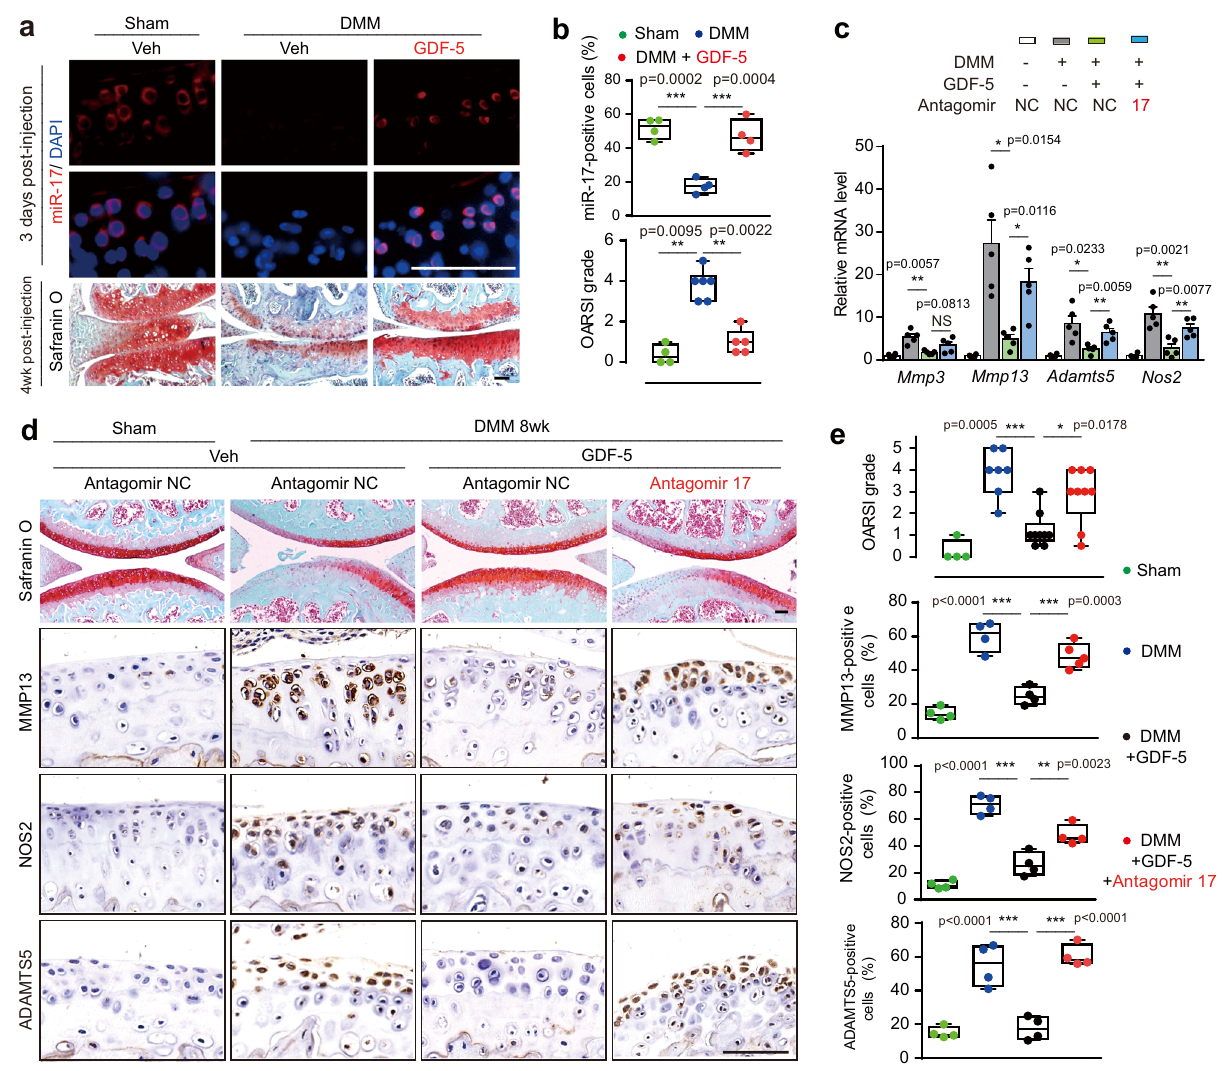
Fig. 3 Endogenous miR-17 was upregulated by GDF-5 to suppress cartilage destruction in DMM mice. a , b FISH for miR-17 and safranin O/fast green staining of joint sections ( a ), and quanti fi cation of miR-17-positive cells and OARSI scores ( b ). Veh (PBS) or GDF-5 (100 ng per injection) was injected weekly for 4 weeks, beginning at 4 weeks after sham or DMM surgery. n = 4 mice per group for cell counting. For OARSI grade, n = 4 mice (sham); n = 6 mice (DMM); n = 5 mice (DMM + GDF-5). c – e qRT-PCR analysis of catabolic genes ( c ); safranin O/fast green staining and IHC staining for MMP13, ADAMTS5 and NOS2 ( d ); OARSI scores; and quanti fi cation of cells positive for immunostaining ( e ) from knee joints. A combination of GDF-5 (0 or 100 ng) and 3 nmol of the antagomir (antagomir-17 or antagomir-NC) was injected intra-articularly. The injections were performed weekly for 4 weeks, beginning at 4 weeks after sham or DMM surgery. n = 4 biologically independent samples (sham + antagomir-NC) and n = 5 biologically independent samples for other groups in ( c ). For OARSI scores, n = 4 mice (sham); n = 7 mice (DMM); n = 9 mice (GDF-5 + antagomir-NC, GDF-5 + antagomir-17). For MMP13 staining, n = 5 mice (antagomir-17); n = 4 mice in other groups. For NOS2 and ADAMTS5 staining, n = 4 mice per group. All scale bars, 100 μ m. Data were presented as boxplots or mean ± s.e.m. Boxplots: center line, median; box limits, 25th to 75th percentiles; whiskers, min to max. * P < 0.05, ** P < 0.01, and *** P < 0.001. One-way ANOVA with Bonferroni ’ s test for percentage of positive cells; two-sided Mann – Whitney U test for OARSI grade; two-sided Student ’ s t test for ( c ). Source data are provided as a Source Data fi